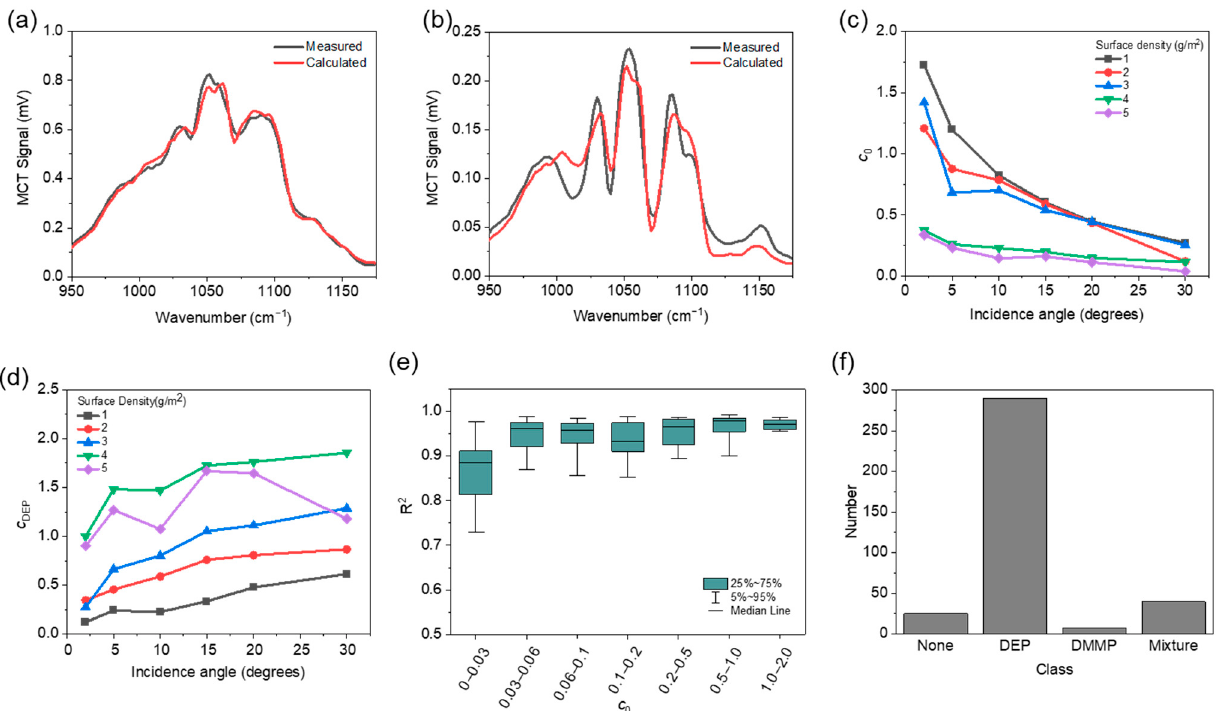
Figure 4. ( a , b ) Measured (black) and calculated (red) diffuse reflection spectra for DEP coated substrate with Ra of 1.6 µ m, at incidence angle of 5 ◦ for surface density of ( a ) 2 g/m 2 and ( b ) 4 g/m 2 . ( c , d ) Extracted power scaling factor ( c ) c 0 and extracted absorbance scaling factor ( d ) c DEP from measured data for different surface densities of DEP and different incidence angles using the substrate with Ra of 1.6 µ m. ( e ) Distribution of the coefficient of determination R 2 according to c 0 . ( f ) Result of None, DEP, DMMP, and Mixture of DEP and DMMP.